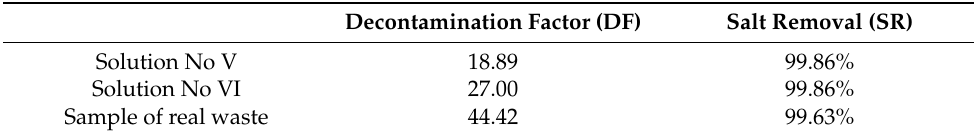
Table 8. Summary of the results from treating model solutions and real waste using the developed ED